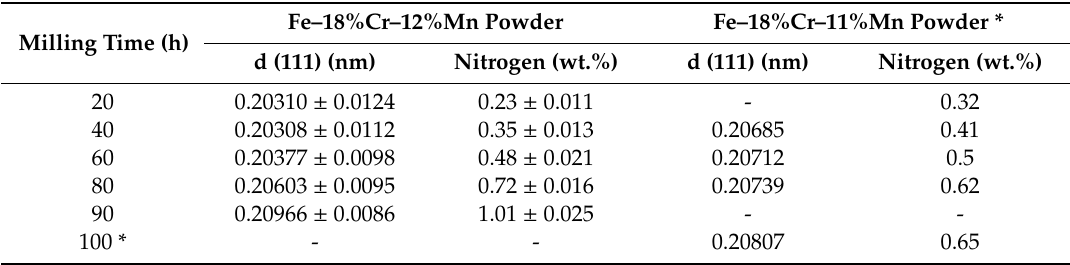
Table 1. Internal lattice d-space and nitrogen content of the Fe–18%Cr–12%Mn powder and literature data for Fe–18%Cr–11%Mn elemental powders of Fe, Cr, and Mn ball milled in